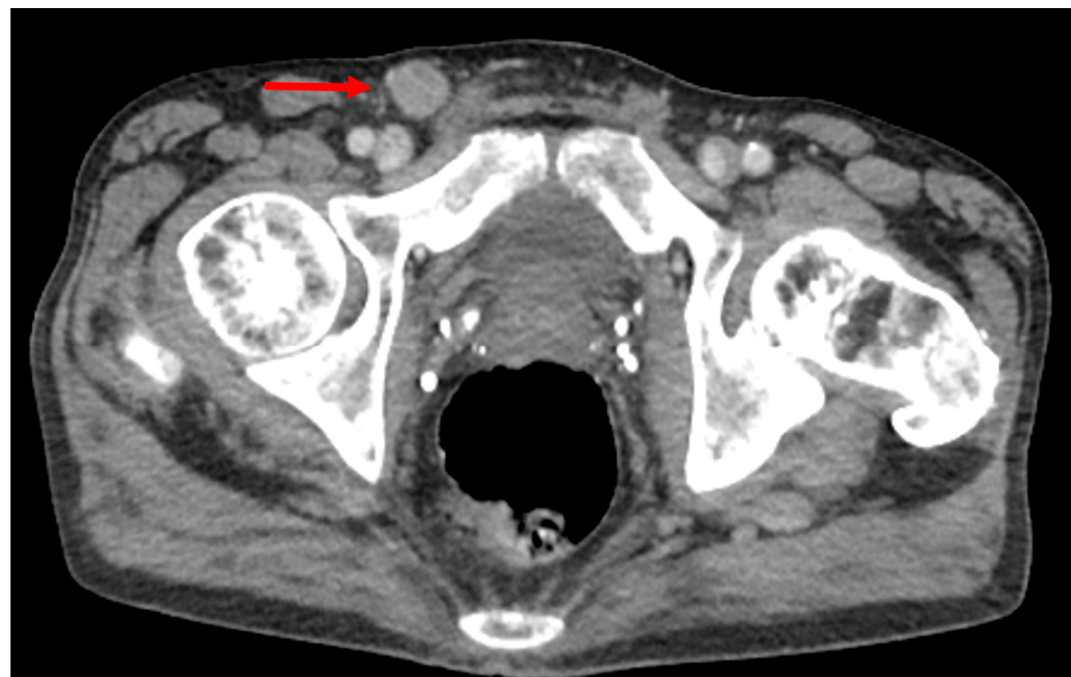
Figure 1. 55-year-old male with newly diagnosed penile cancer presents for initial staging CT of the abdomen and pelvis. Axial contrast enhanced CT through the level of the pelvis demonstrates an abnormally rounded, enlarged right inguinal lymph node (arrow) that was confirmed to be metastatic at time of surgery.